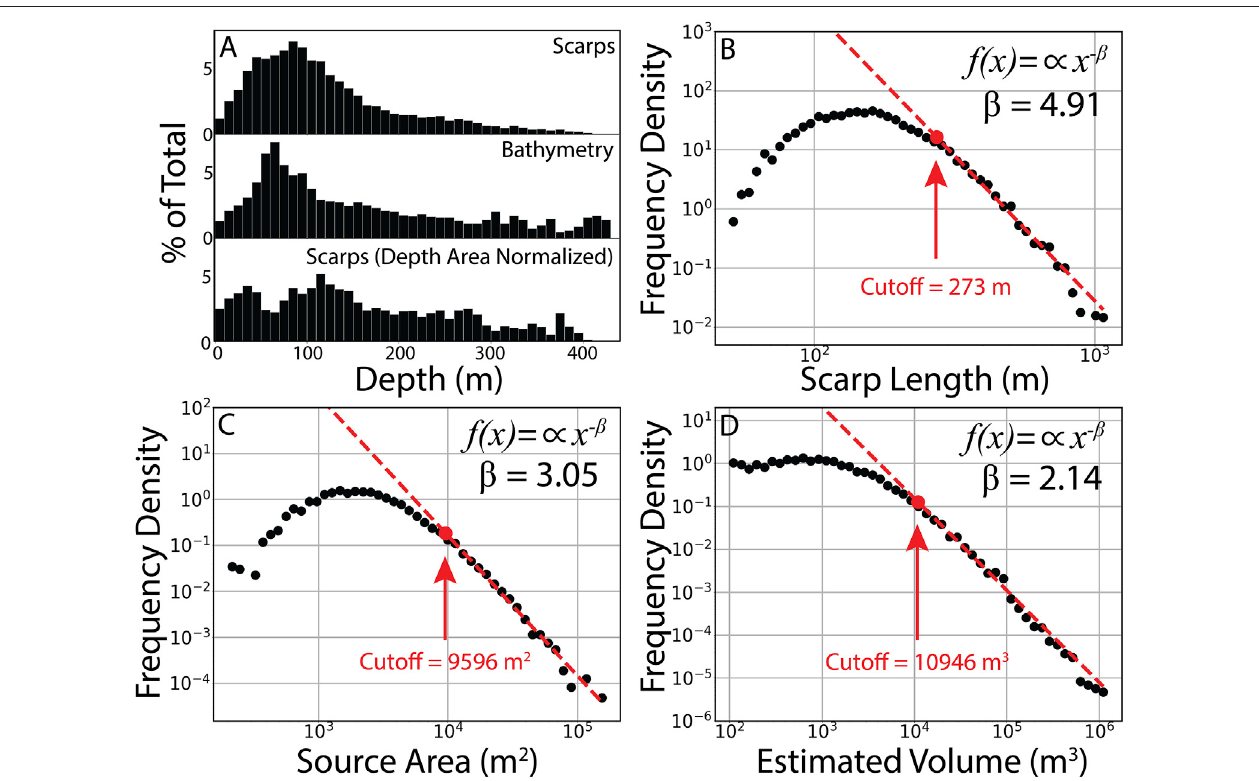
FIGURE 7 | (A) Depth-frequency plots for all mapped landslide scarps and bathymetric grid cells expressed as a percentage of total scarps and total grid cells, respectively. Under-sampling at shallow depths is likely a result of unavailable near-shore bathymetry. Lower panel shows normalized values for scarp depth-frequency (top panel divided by middle panel), with an apparent decrease in frequency at greater depths. Lack of data at greater depths is likely a result of lower available multi- beam sonar resolutions and thus poorer discernability of scarps at these depths. (B – D) Magnitude-frequency density plots for scarp length, source area, and estimated source area volume for submarine landslide scarps mapped in this study. Best fi t power law and minimum values were calculated using the maximum likelihood method (MLE) after (Clauset et al., 2009) with logarithmic bins. Cutoff values representing the MLE validity domain are shown in red. Power law exponents ( β ) arereportedforeach fi t.Sourceareawasderivedforeachscarpbyconnectingscarpsattheirendpoints.Volumewasestimatedbydifferencingthebathymetricsurface within the source area footprint from a best- fi t polynomial surface for each three-dimensional scarp representation. Negative volumes resulting from uncertainty in the method and a dominance of shallow landslides in these environments are not shown (see Supplementary Figure S1